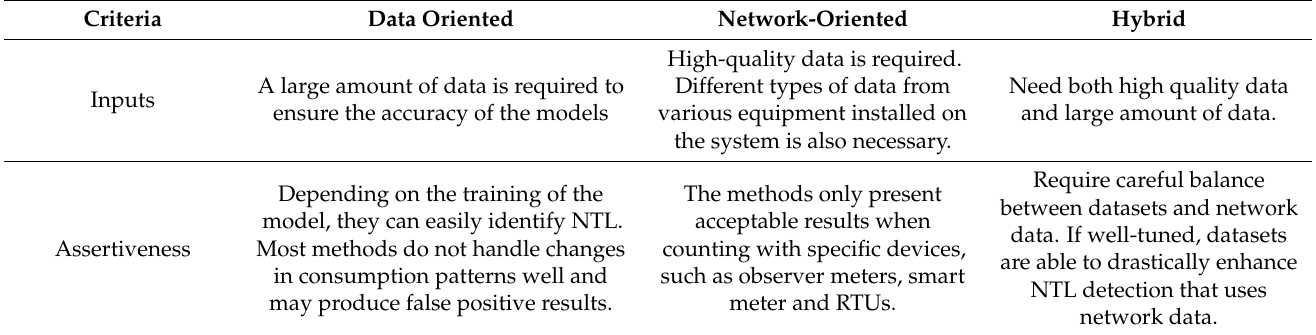
Table 4. Comparison between non-hardware-based NTL detection